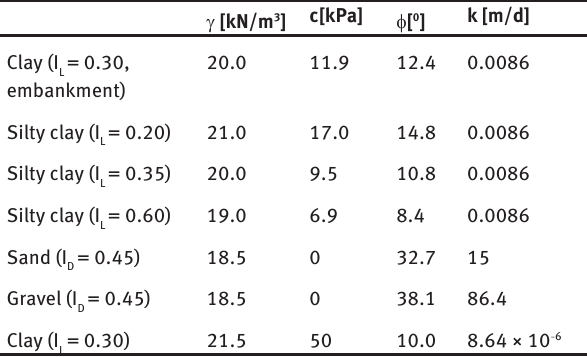
Table 1: Most important material parameters used in analysis of shallow